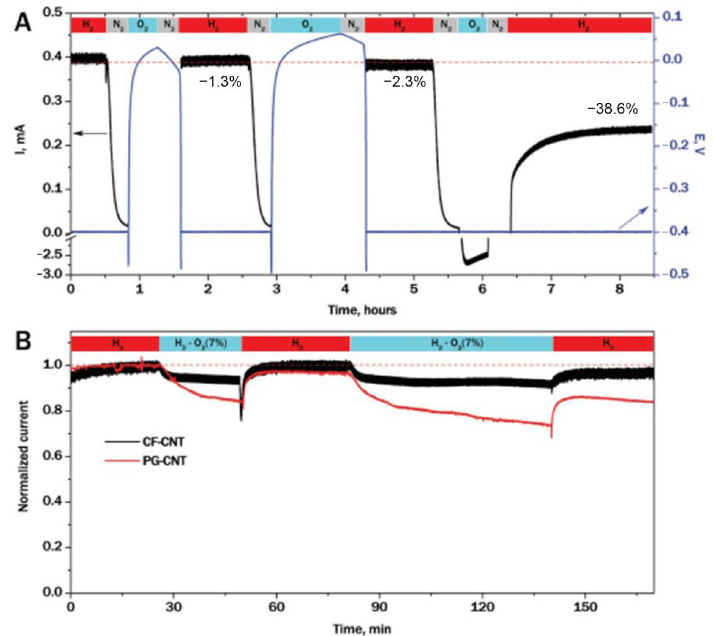
Figure 14 Figure 14. Chronoamperometric response for H 2 oxidation by A. aeolicus HASE embedded in a CNT-modified carbon felt electrode showing the inactivation of the enzyme by ROS electrochemically produced ( A ) and protection by a porous matrix ( B ). Reproduced with permission from